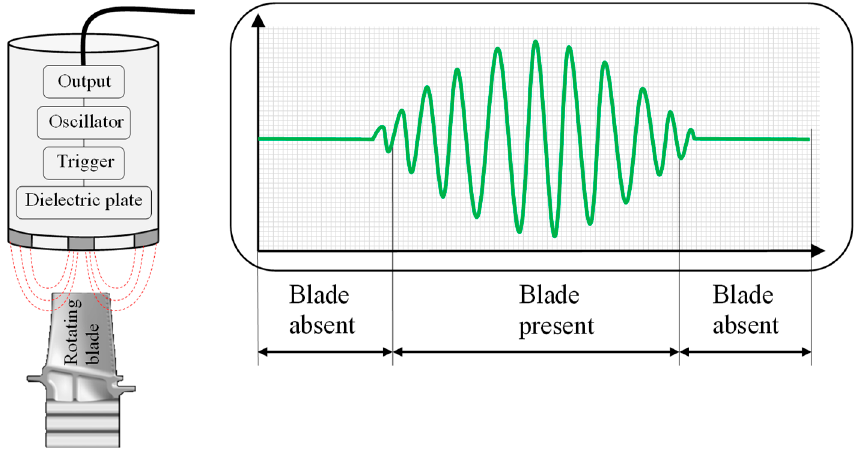
Figure 14 . Principle capacitance sensor . Figure 14. Principle capacitance